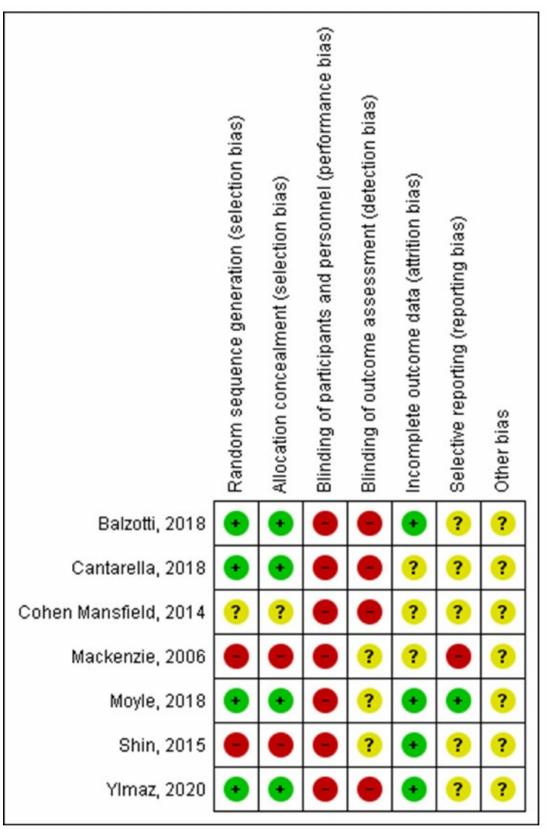
Figure 2. Risk of bias of studies included in the systematic review (Balzotti, 2018 [31], Cantarella, 2018 [28], Cohen Mansfield, 2014 [32], Mackenzie, 2006 [33], Moyle, 2018 [29], Shin, 2015 [20], Ylmaz, 2020 [30]).